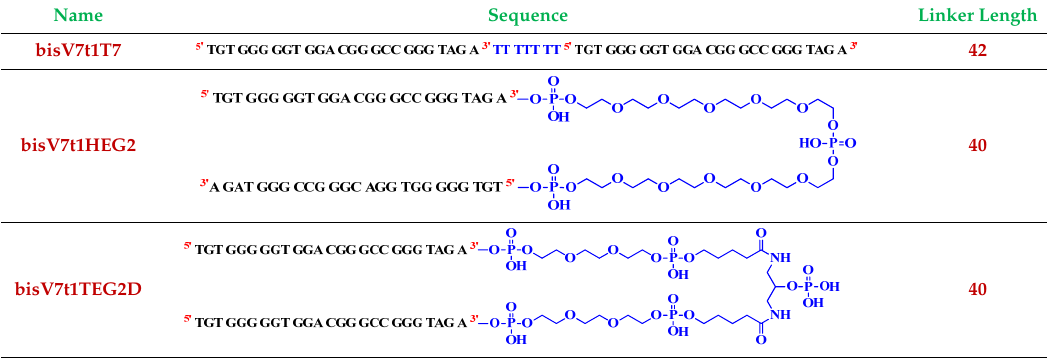
Table 1. Molecular structure of the covalent V7t1 dimers investigated in this study.